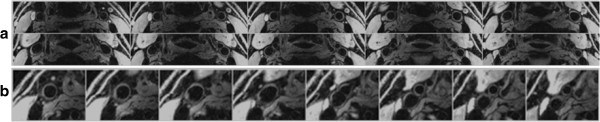
Representative contiguous slices about the carotid bifurcation from two healthy subjects. a) Seven bilateral images from a 26 year-old subject. b) Eight magnified views of the right carotid artery of a 41 year-old subject.